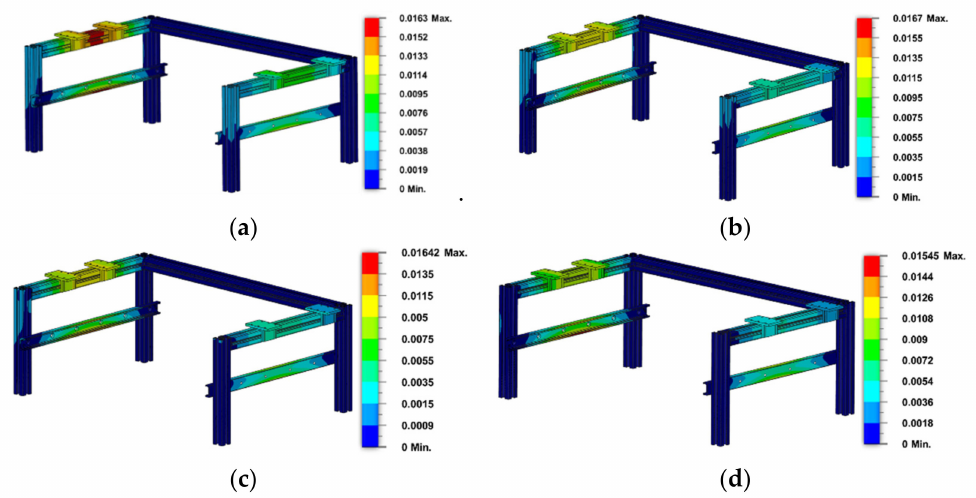
Figure 9. Contour of Displacement on Overhead Crane: ( a ) Standard Type; ( b ) Lightweight Type; ( c ) Economy Type; ( d ) High-Rigidity Type.